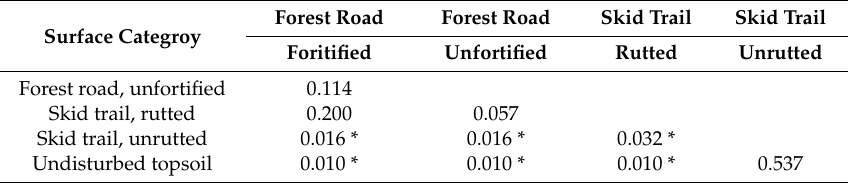
Table 6. Significance of surface type differences regarding runoff volumes, Mann–Whitney